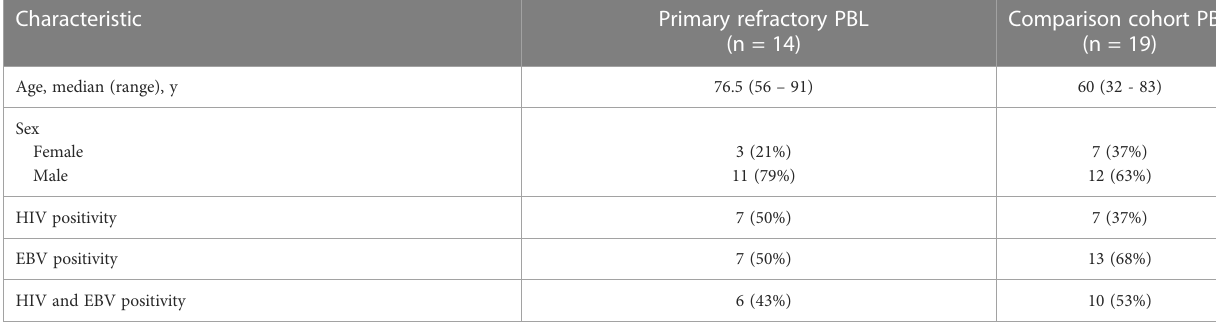
TABLE 1 Baseline clinicopathological characteristics in primary refractory